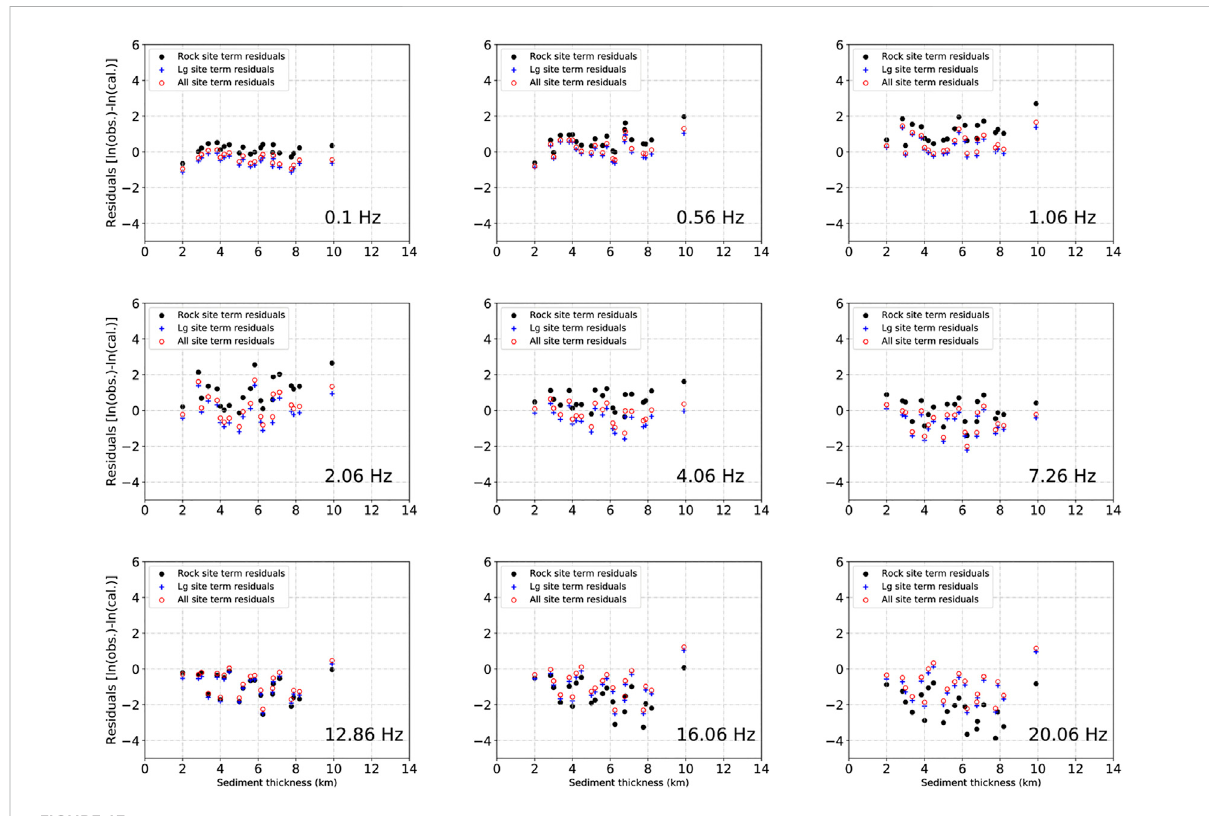
FIGURE 13 Same as Figure 11 but for the 15 September 2021 Ms 6.0